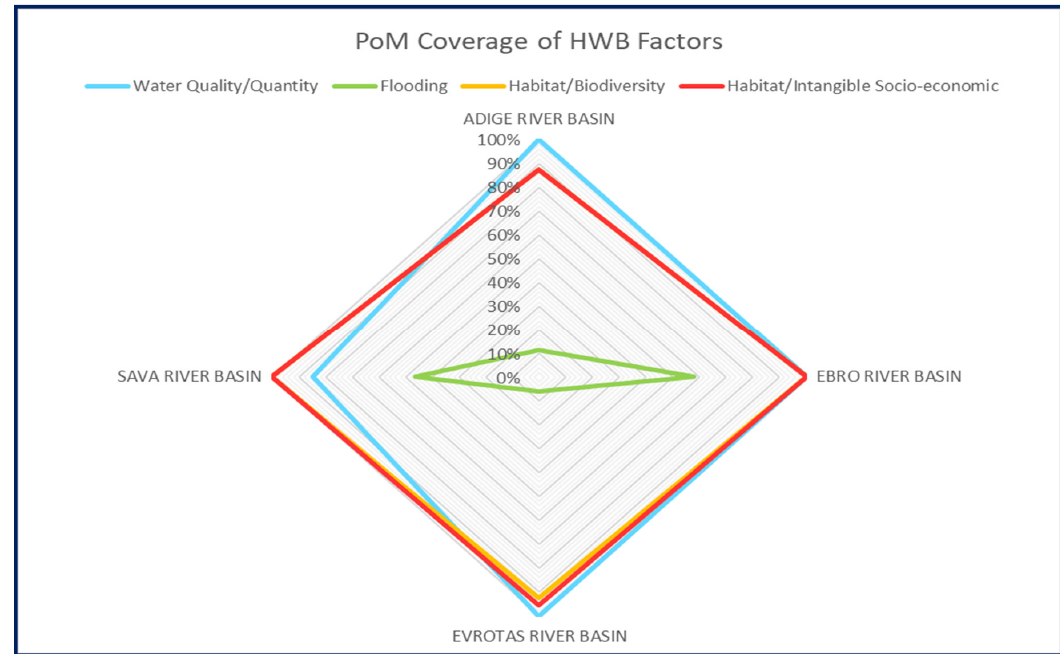
Figure 4. The coverage of Human Wellbeing (HWB) factors within the GLOBAQUA River Basins (GARBs).